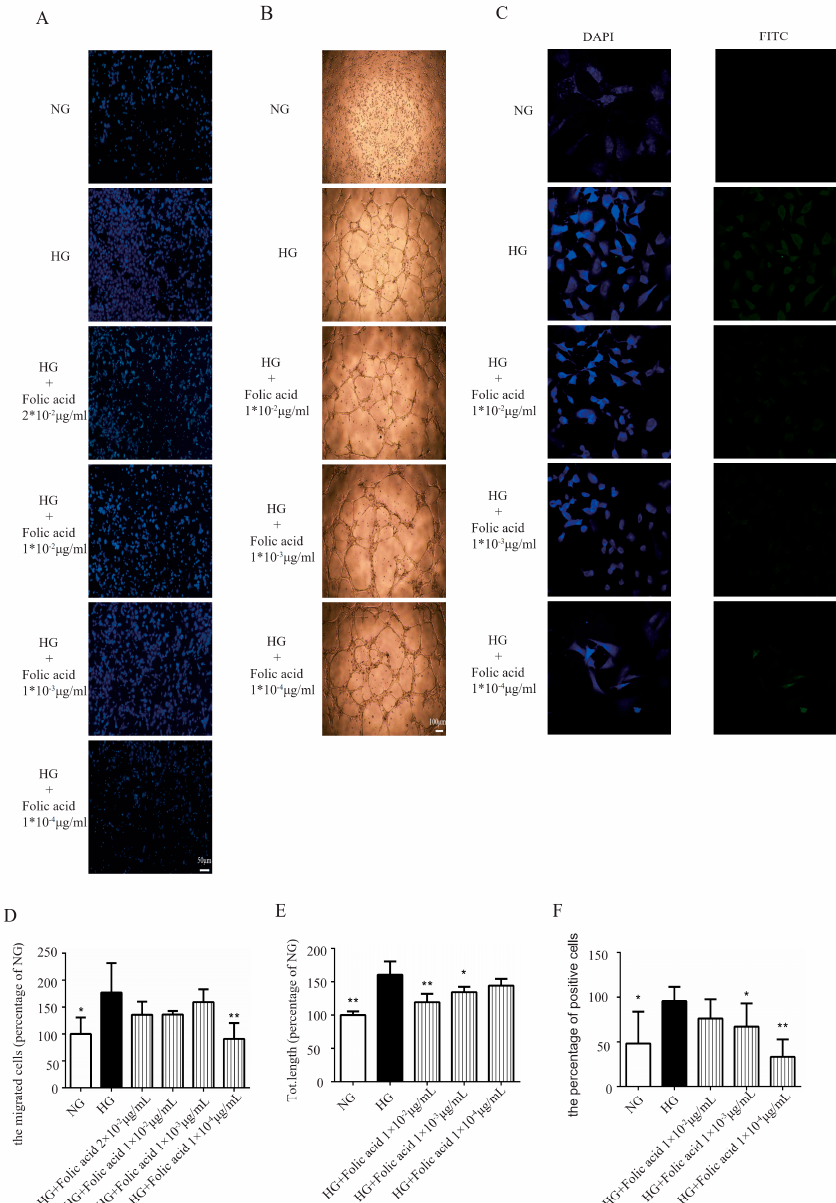
Figure 3. Folic acid inhibited the migration capability, total tube length and proliferation of the RVECs. The effect of folic acid (0.02–0.0001 µ g/mL; A , D ) on the migration of RVECs was assessed by the Transwell assay. Scale bar, 50 µ m. The effect of folic acid (0.01–0.0001 µ g/mL; B , E ) on the tube formation of RVECs was assessed by the tube formation assay. Scale bar, 100 µ m. The effect of folic acid (0.01–0.0001 µ g/mL; C , F ) on the proliferation of RVECs was assessed by BrdU assay. The data was presented as means ± SD ( n = 3–12). * p < 0.05, ** p < 0.01, compared with HG-treated cells. Table 3. The partial results of the molecular docking.